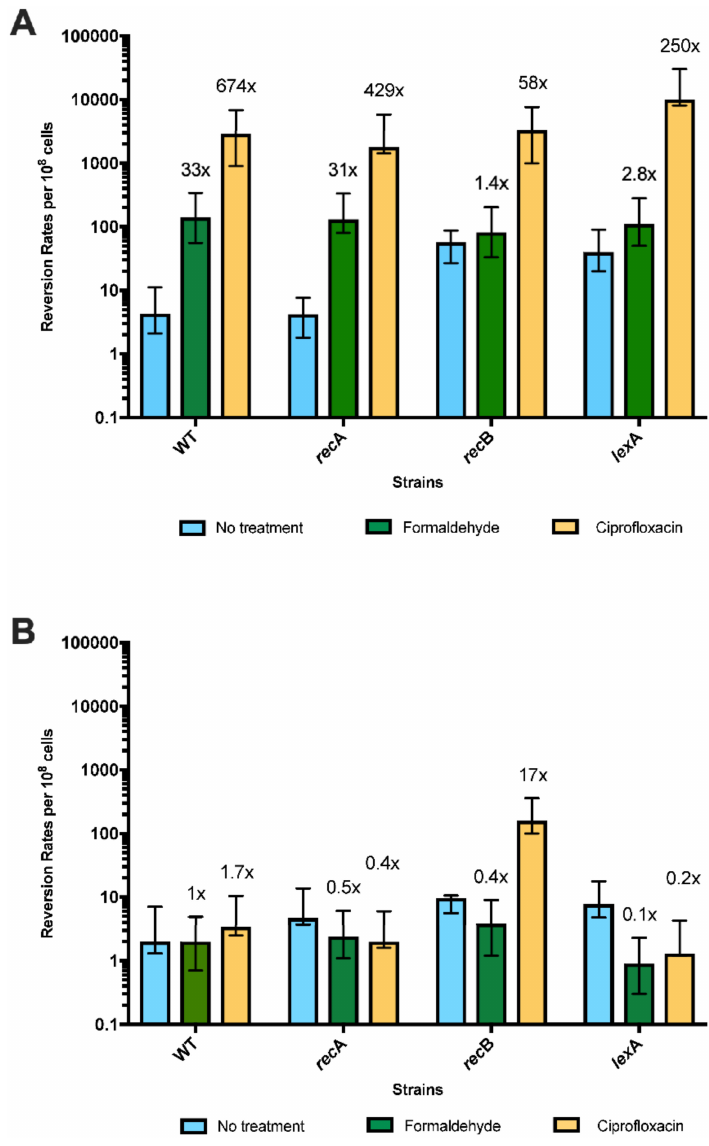
Figure 9. Comparison of reversion rates of lacZ QP leading (QP5) and lagging strand (QP6) mutational reporters after treatment with formaldehyde and ciprofloxacin. Data show reversion rates per 10 8 cells from at least 6 multiple trials performed in different days. Error bars represent 95% confidence